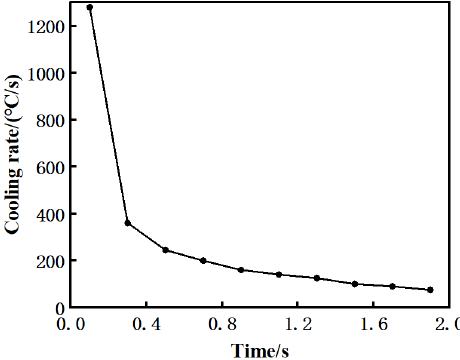
Figure 8. Cooling rate of path 2 with cooling time of 0–2 s.